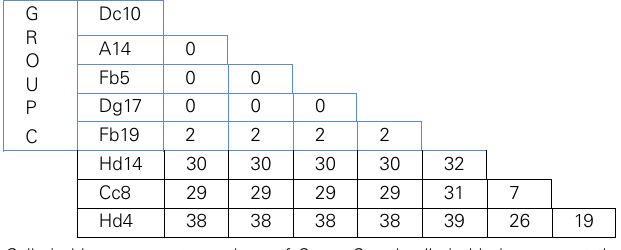
Table 5 | Pairwise comparison of number of nucleotide differences within polytomous Group C defined on the maximum likelihood